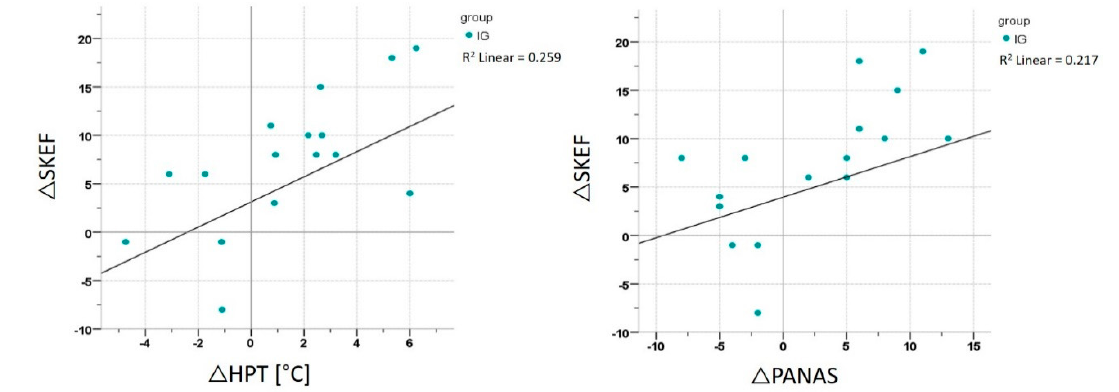
Figure 6. Correlation analysis IG. Correlation between the SKEF and the PANAS Positive Affect Scale and HPT for the IG (intervention group).